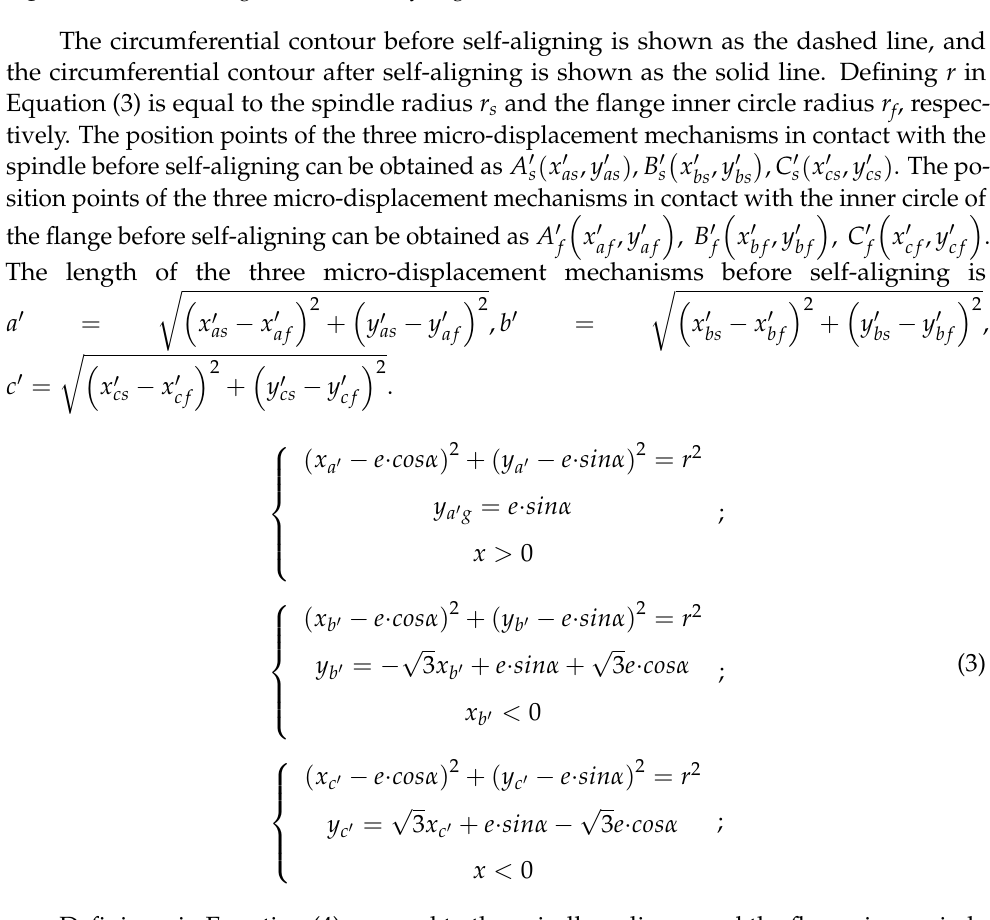
Defining r in Equation (4) as equal to the spindle radius r s and the flange inner circle radius r f , respectively. The position points of the three micro-displacement mechanisms in contact with the spindle after self-aligning can be obtained as A s ( x as , y as ), B s ( x bs , y bs ), C s ( x cs , y cs ). The position points of the three micro-displacement mechanisms in contact with the inner circle of the flange after self-aligning can be obtained as A f ( x af , y af ), B f ( x bf , y bf ), C f ( x cf , y cf ).The length of the three micro-displacement mechanisms after self-aligning is 𝑎 =